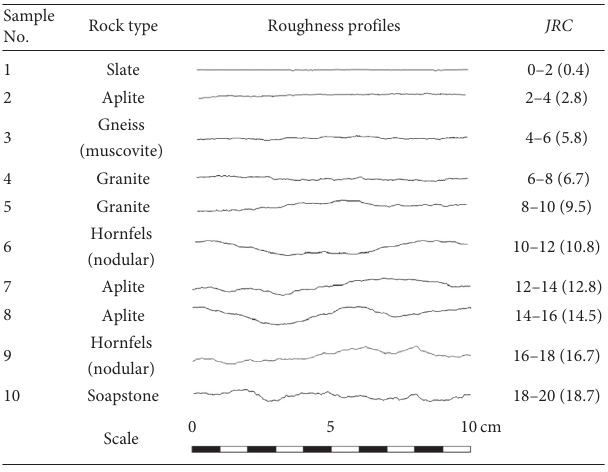
Table 1: Ten typical roughness profiles [3]. Sample